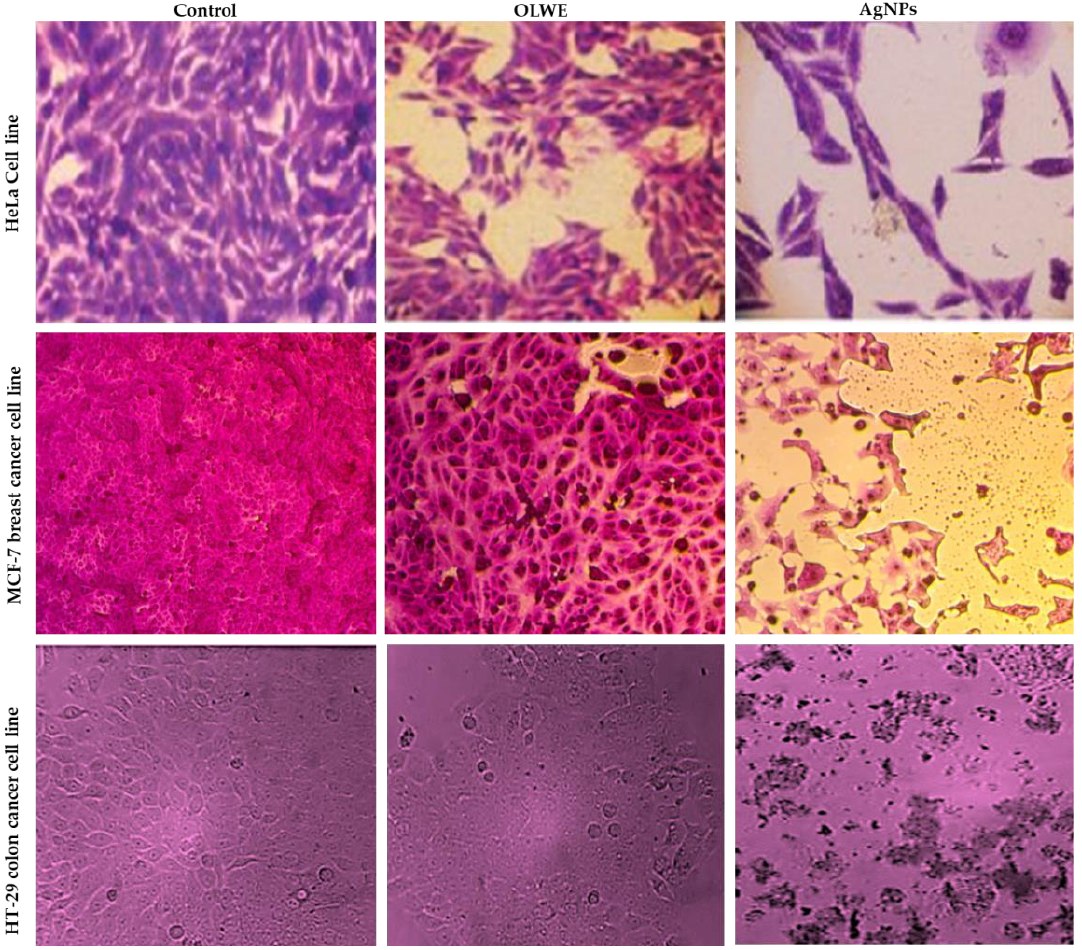
Figure 4. Microscopic image of the cytotoxic effect of AgNPs and OLWE against the cancer cell lines (MCF-7, HeLa, and HT-29).